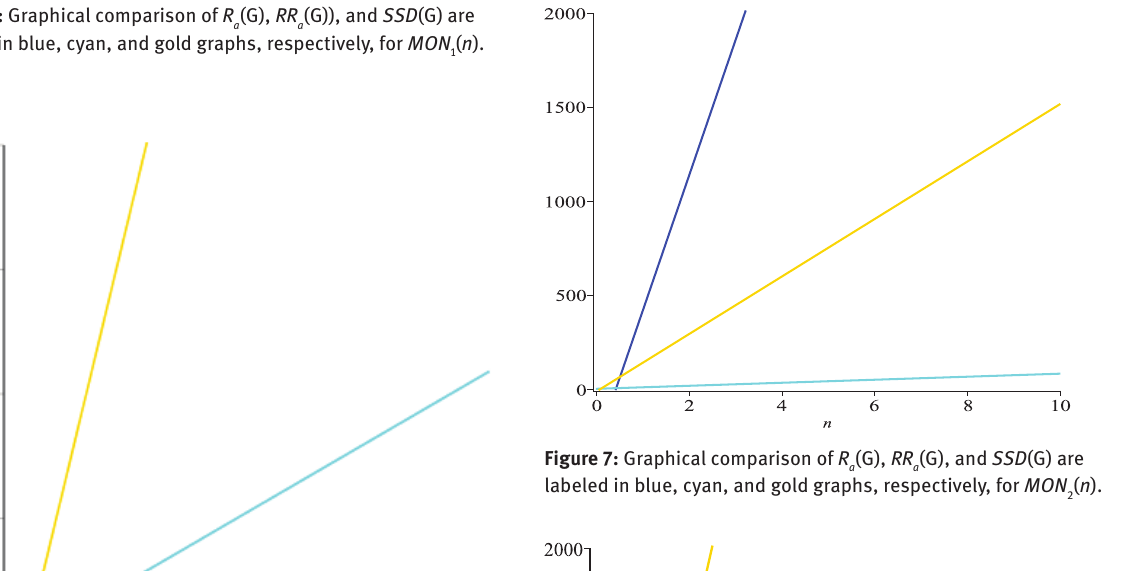
(G), M (G), and MM (G) are 1 2 2 ( n ). 2